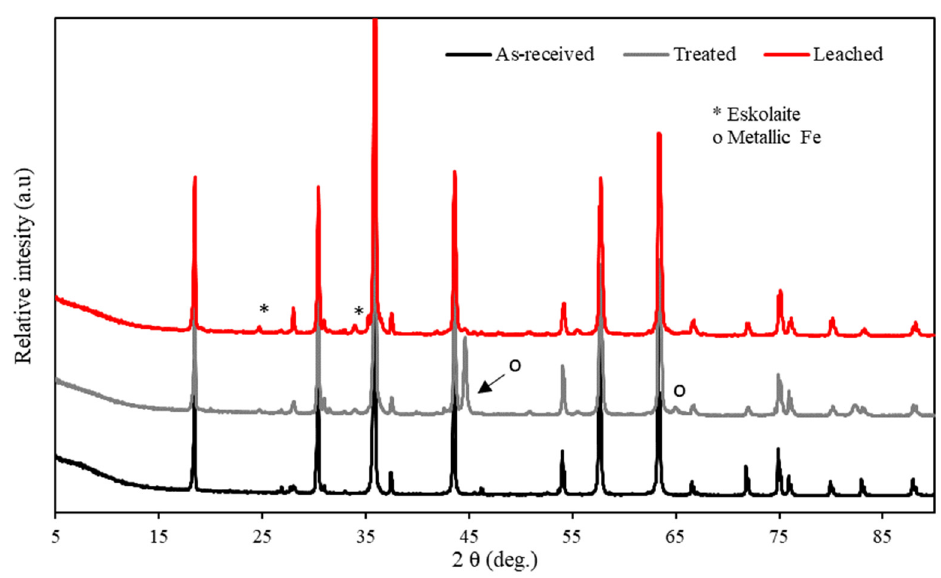
Figure 7. XRD patterns of as-received, treated, and acid-leached chromite. Considering the formation of the eskolaite phase, it is of importance to determine the effect thereof on the reducibility of hydrogen-treated chromite. An Ellingham diagram was compiled with the HSC thermodynamics program to indicate the change in the reduction ∆ G ◦ of pure chromite (Cr 2 FeO 4 ) and eskolaite (shown as Cr 2 O 3 ) by C (Figure 8).